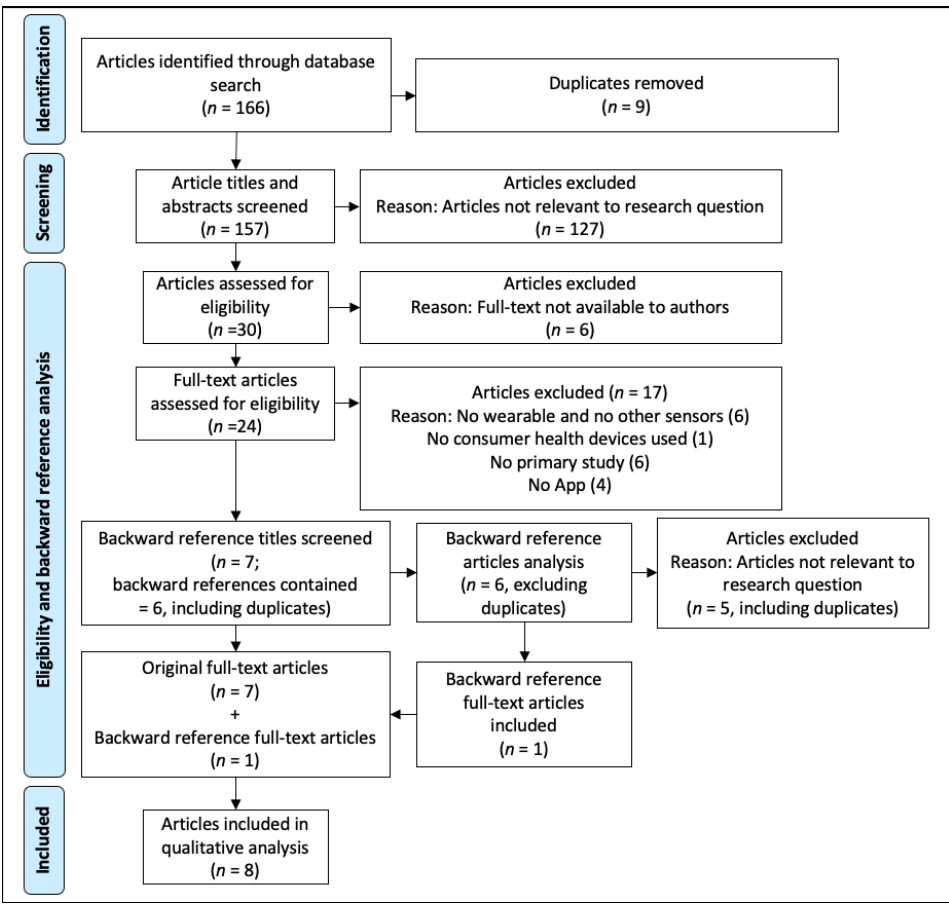
Figure 1. PRISMA flow diagram of the literature screening process. Table 2. Overview of the studies included in the systematic review, with a focus on the study protocols.